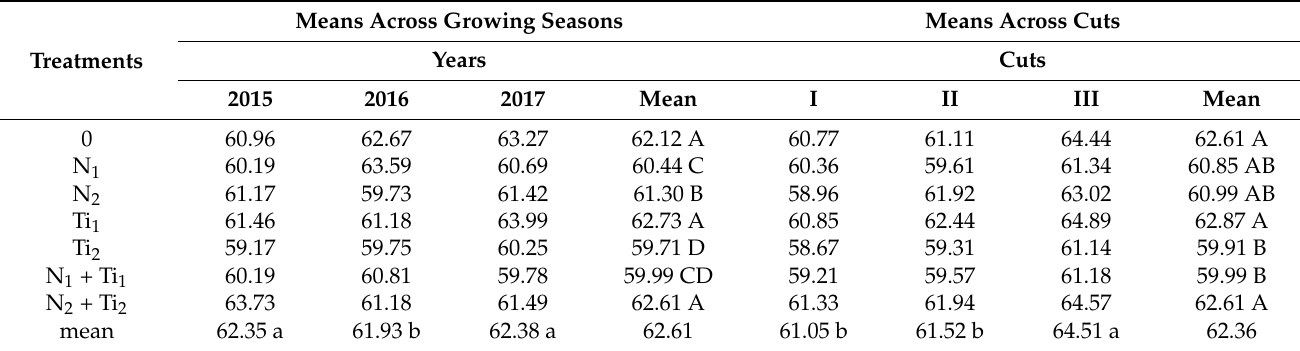
Table 5. Dry matter digestibility (DMD) of Festulolium braunii